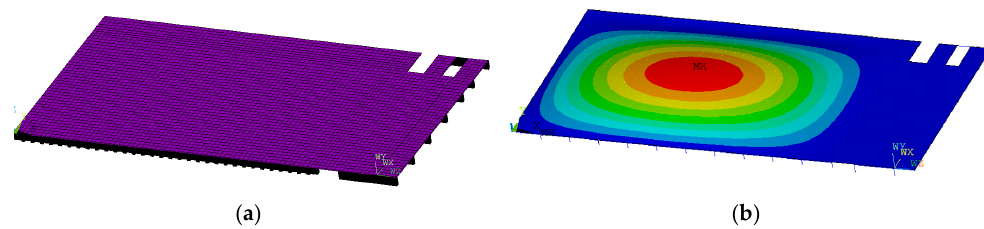
Figure 13. ( a ) FE model of the analyzed slab and ( b ) first eigen shape of the slab f 0 =1.97 Hz.